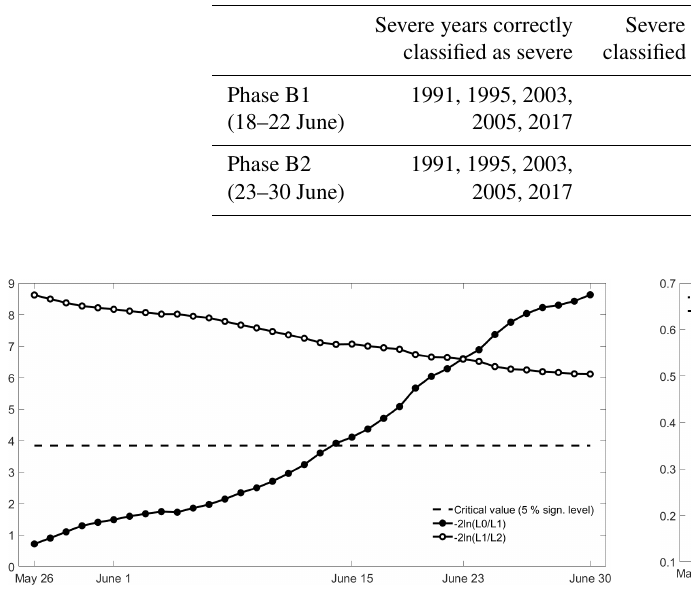
Figure 7. Temporal evolution of the log-likelihood ratio statistics − 2ln (L 0 /L 1 ) between the null model and the model with one co- variate and − 2ln (L 1 /L 2 ) between the model with one covariate and the model with two covariates. The horizontal dashed line rep- resents the critical value for the statistic at the 5% significance level.